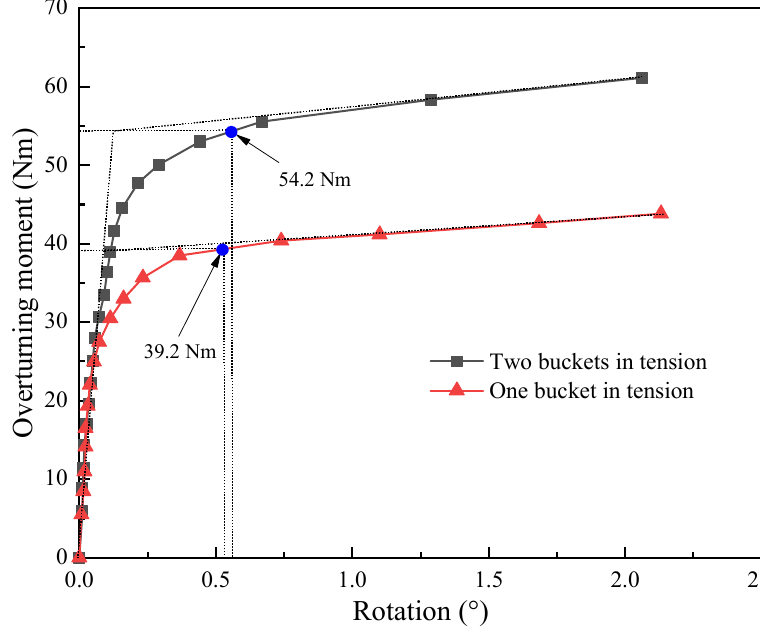
Figure 5. Measured moment-rotation response.